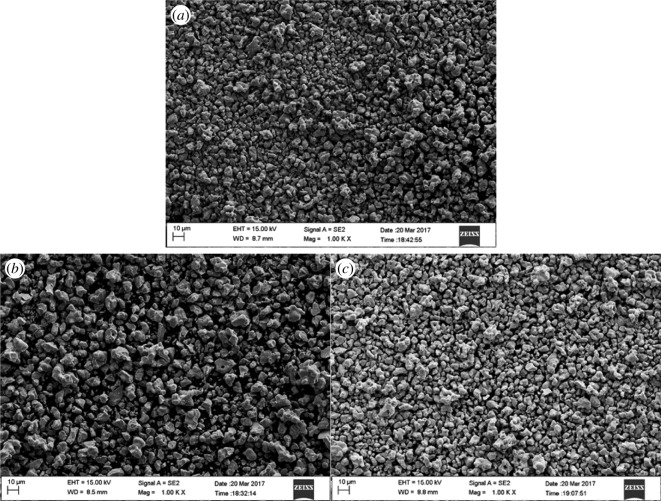
SEM images of the (a) YBaCo4O7+δ, (b) Y0.95Ti0.05BaCo4O7+δ and (c) Y0.5Dy0.5BaCo4O7+δ samples.